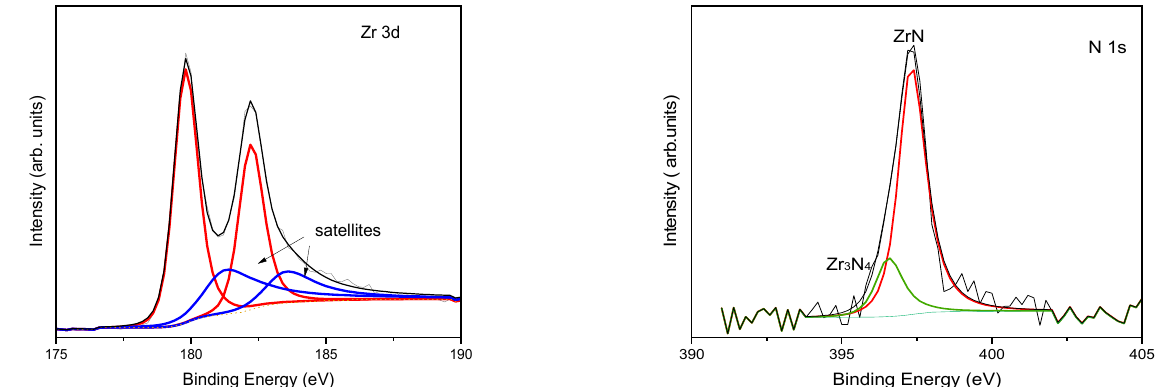
Figure 4. Peak fitting results of Zr 3d and N 1s HR (high resolution) regions at level 2 from the surface for sample ZrN B.